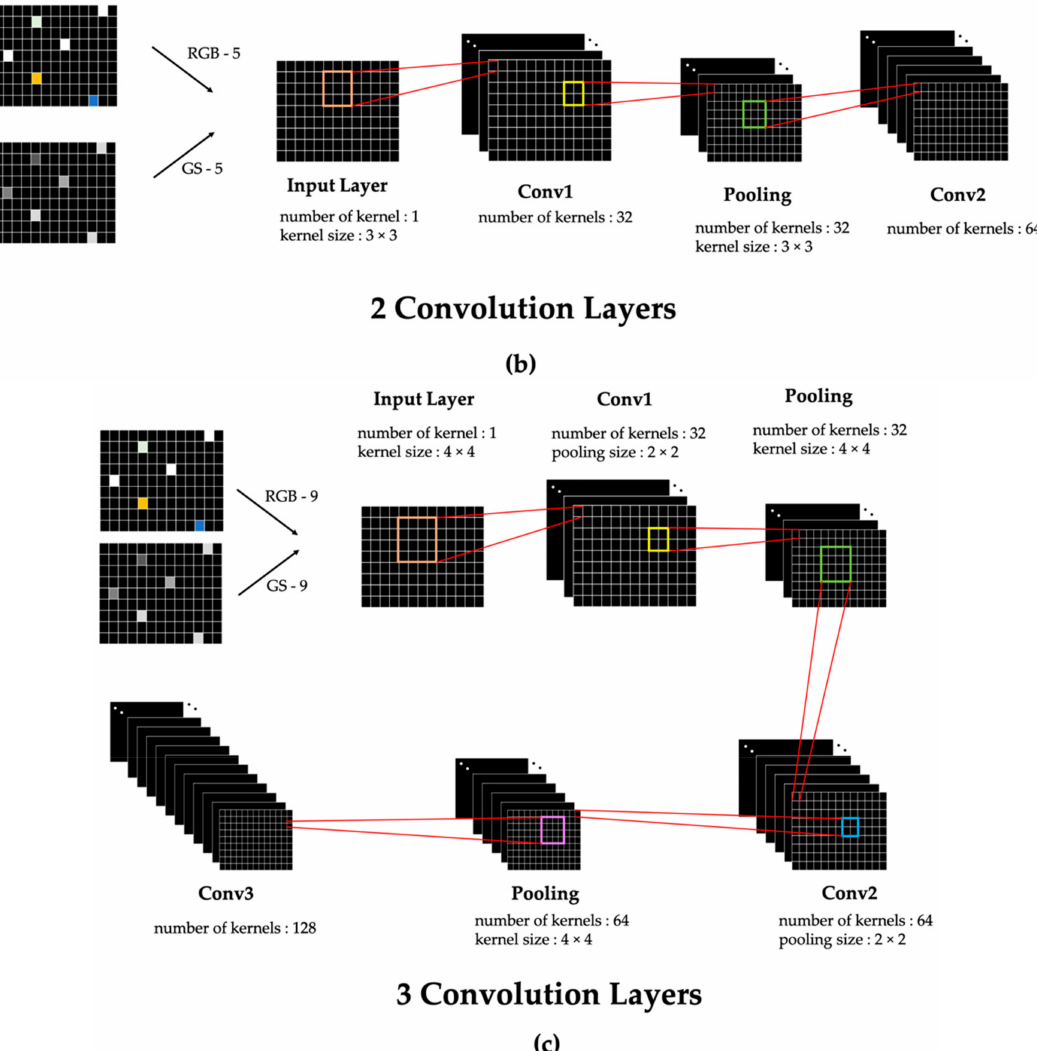
Figure 3. Example CNN designs: ( a ) RGB-1 and GS-1 scenarios with a single convolution layer and 2 × 2 size of kernel, ( b ) RGB-5 and GS-1 scenarios with 2 convolution layers and 3 × 3 size of kernel, ( c ) RGB-9 and GS-9 scenarios with 3 convolution layers and 4 × 4 size of